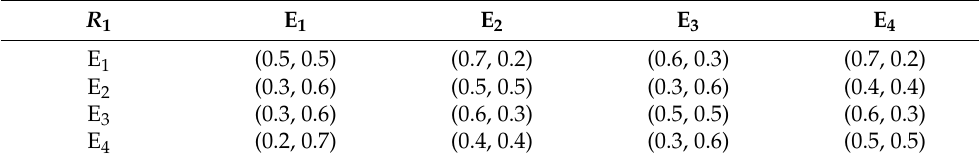
Table 10. The expert group’s intuitionistic-preference relationship for professional position (C 1 ).